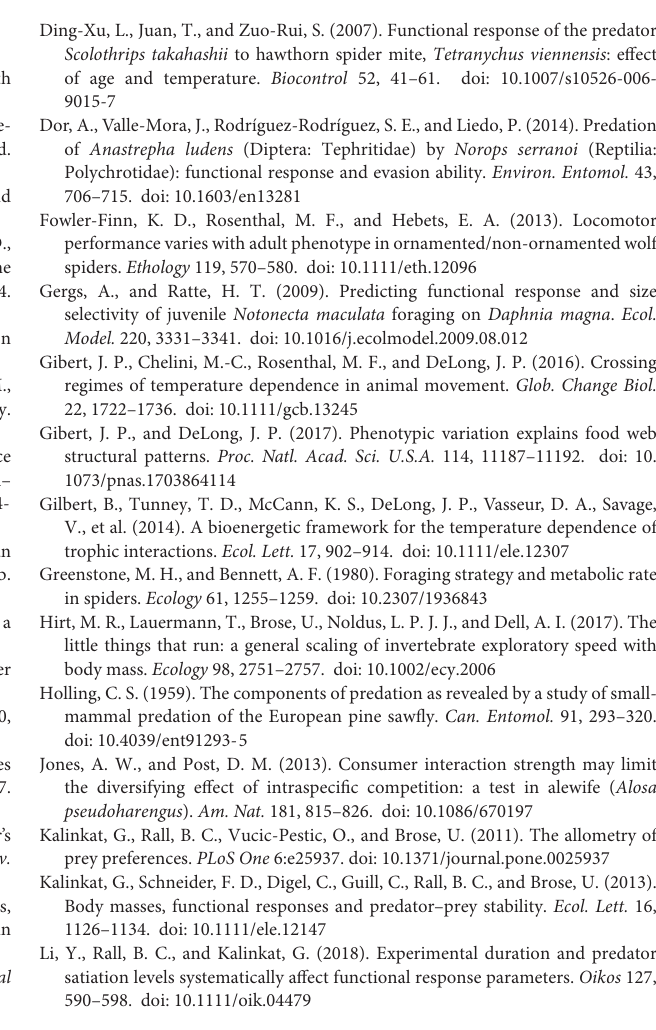
Supplementary Figure 1 | Differences in bootstrapped estimates of functional response parameters space clearance rate (A) and handling time (B) . These differences are pairwise differences between all bootstrapped parameter estimates for male and female Schizocosa mccooki wolf spiders. The distribution of pairwise differences thus indicates the probability that the parameters differ between male and female. For space clearance rate, the mode of the differences is near zero, indicating no difference. For handling time, the distribution crosses zero at the 97th percentile, indicating that the parameters are different with p = 0.03. Supplementary Figure 2 | Correlation matrix for traits, movement variables, and residual foraging performance across 48 Schizocosa mccooki wolf spiders. Numbers indicate Pearson’s correlation coefficient, indicated in red if significant ( p < 0.05) and black otherwise, with a least squares regression line shown only for significant correlations. Variables are leg length (mm), body mass (g), abdomen width (mm), oxygen consumption (g O 2 per min), velocity (cm per sec), time spent moving (min), angular velocity (degrees per sec), number of rotations (frequency), and residual foraging performance (prey